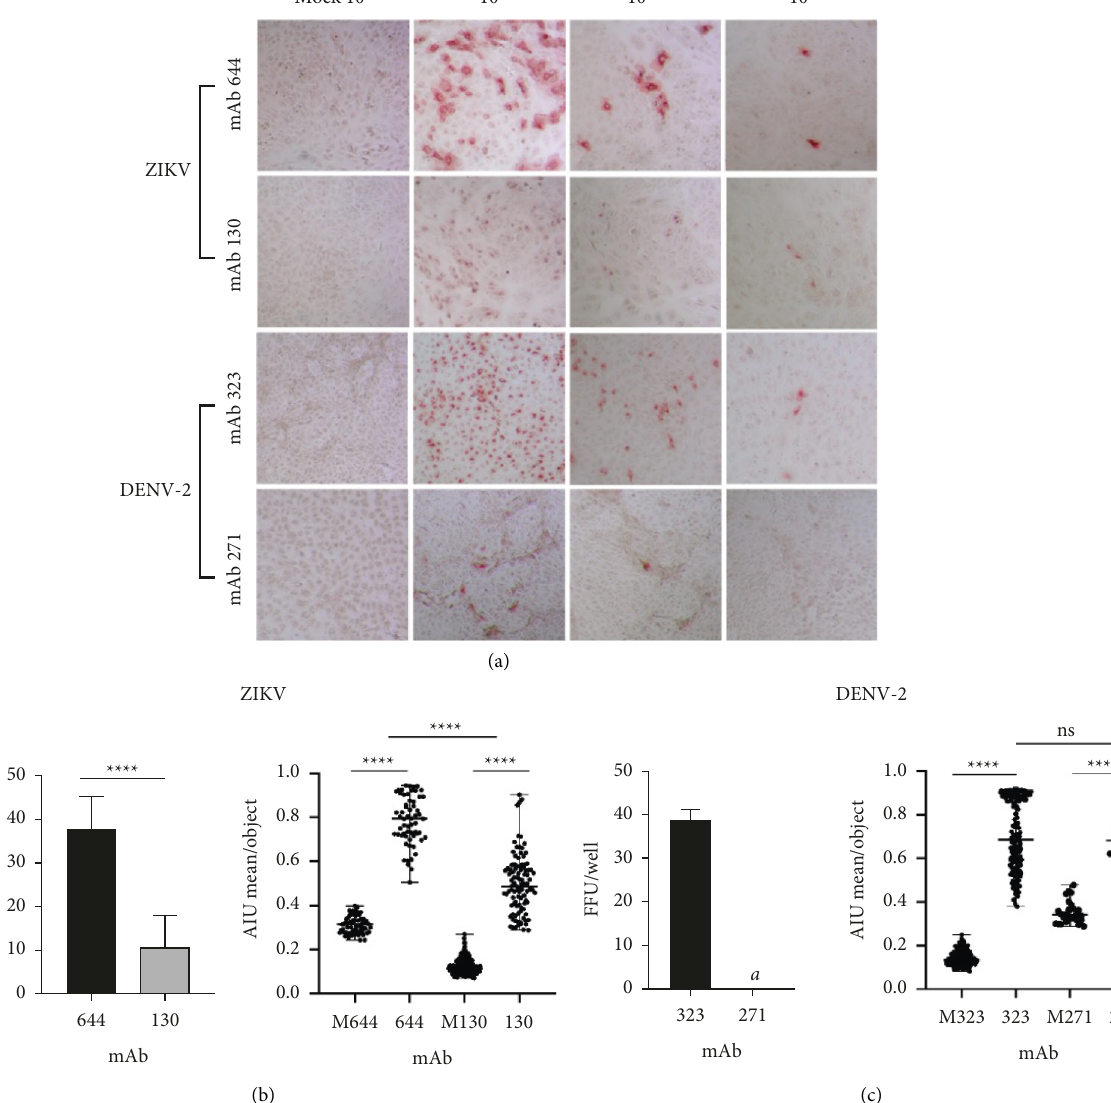
Figure 1: mAb 644 and mAb 323 were more efficient in identifying infectious viral particles of ZIKV and DENV-2, respectively. FFAs were performed at 24 hpi with all antibodies tested at a concentration of 1 μ g/ml. (a) Optical microscopy photographs of FFAs at 10x magnification, comparing different serial dilutions at base 10 in terms of the FFU detected with the different anti-NS1 ZIKV and DENV-2 antibodies and their respective Mocks. (b) Left: Mean ± standard deviation of the number of FFUs counted in the wells at a dilution of 10 − 4 for each of the mAb analyzed. Right: Median ± range of the average AIU per FFU measured for each antibody utilizing the CellProfiler ™ free software. M323: mean Mock-treated cells stained with mAb 323. (c) Left: Mean ± standard deviation of FFUs counted in wells at the 10 − 4 dilution for each anti-DENV antibody. Right: Median ± range of the average AIU per FFU measured for each antibody using the CellProfiler ™ free software. Significant differences between antibodies according to the unpaired t test or Mann–Whitney test are denoted by asterisks ( p < 0 . 0001). a : No foci were found at this dilution. The experiments were carried out in replicates of 6 for each